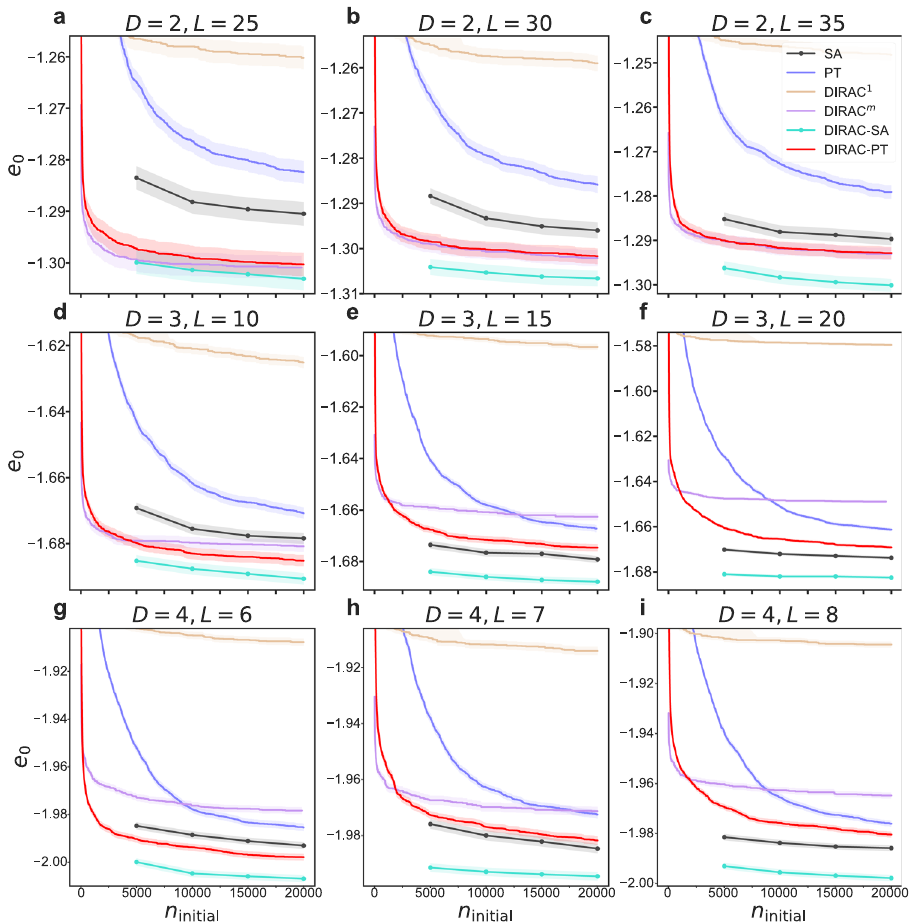
Fig. 5 | Performance of different methods in minimizing the energy. We com- pared the disorder averaged “ ground-state ” energy per spin (predicted by each method),denoteas e 0 ,asafunctionofthenumberofinitialcon fi gurations n initial ,to benchmark various methods on large systems. Since the Greedy algorithm per- formstheworstinminimizingtheenergy,itsresults are notshownhereso thatwe can better compare the performance of other methods. We compared on three dimensions ( D =2,3,4), and for each dimension we consider three different sides ( a – i ).Foreachcase,werun n initial =2×10 4 initialcon fi gurationsforeachmethod.At a given n initial , we chose the lowest energy among all runs for each instance, and averaged the results from 50 independent instances as the fi nal result. We showed their mean and SEM (shaded area) of different algorithms on different sizes. Since